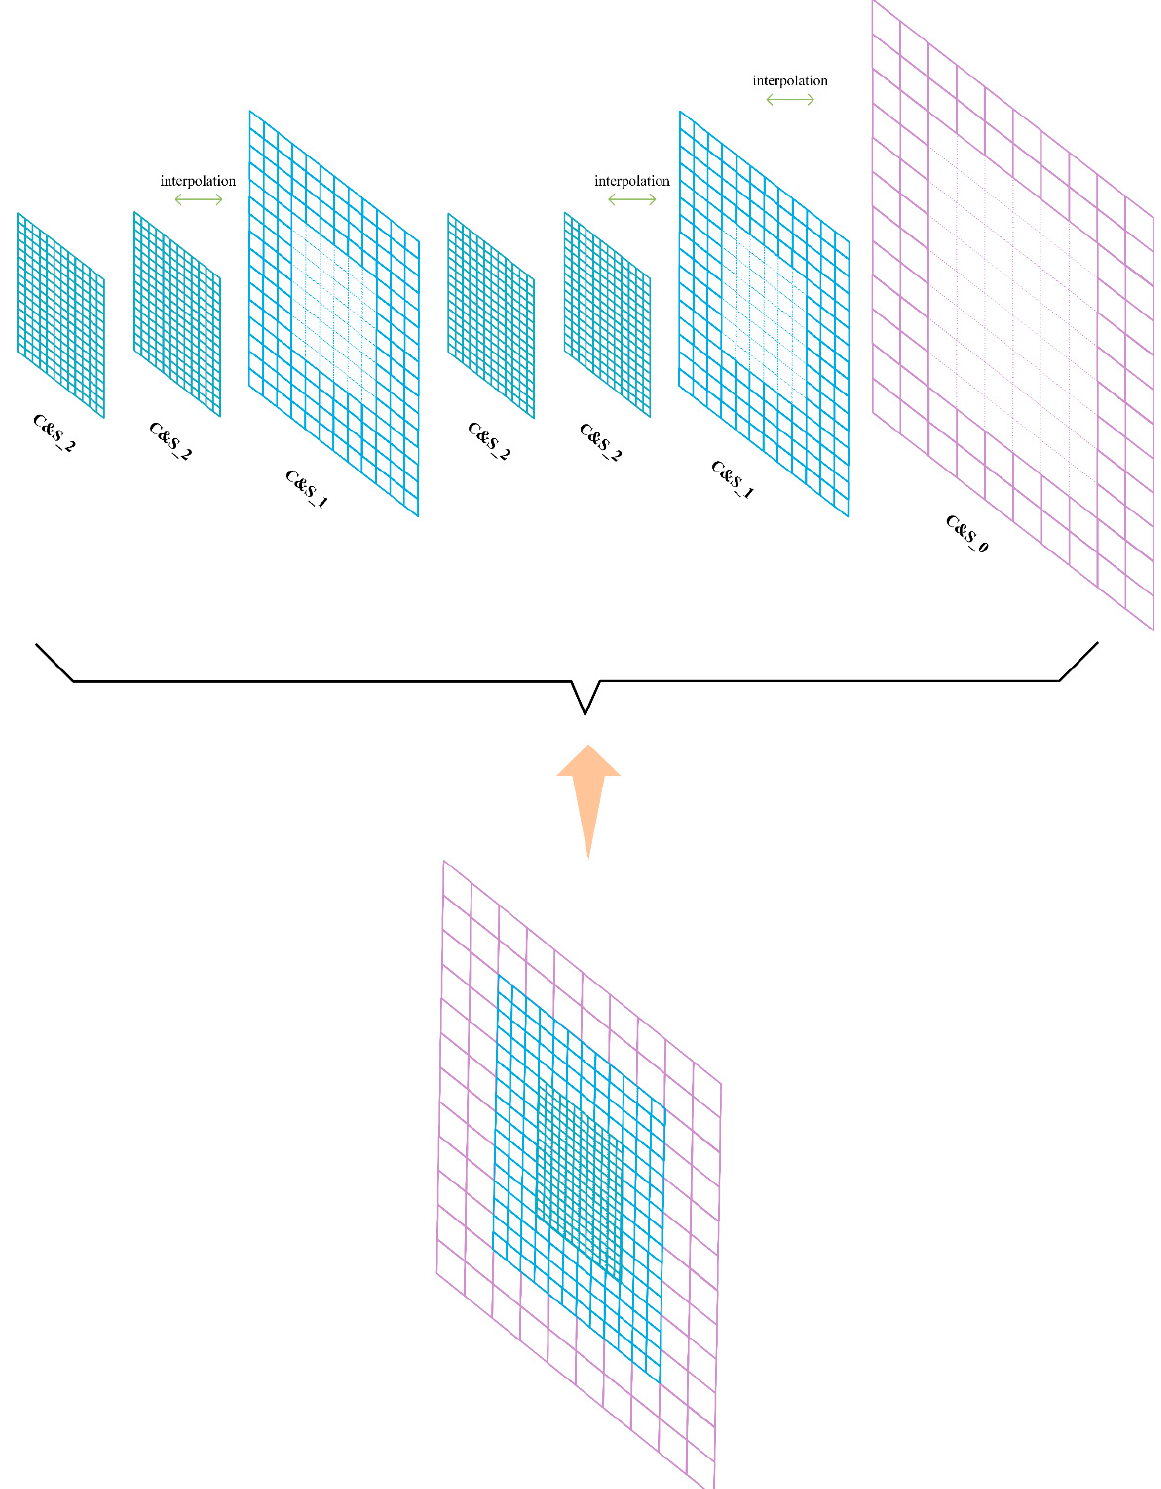
Figure 5. Schematic diagram of the DC method. “C” is for collision computation, “S” is for streaming computation and “C&S” is for collision and streaming computation. The number after the underscore indicates the grid level. The evolutionary calculation of the domain in one iteration step consists of the collision streaming calculation of different patches. The whole procedure is executed in the regular order shown in the figure.